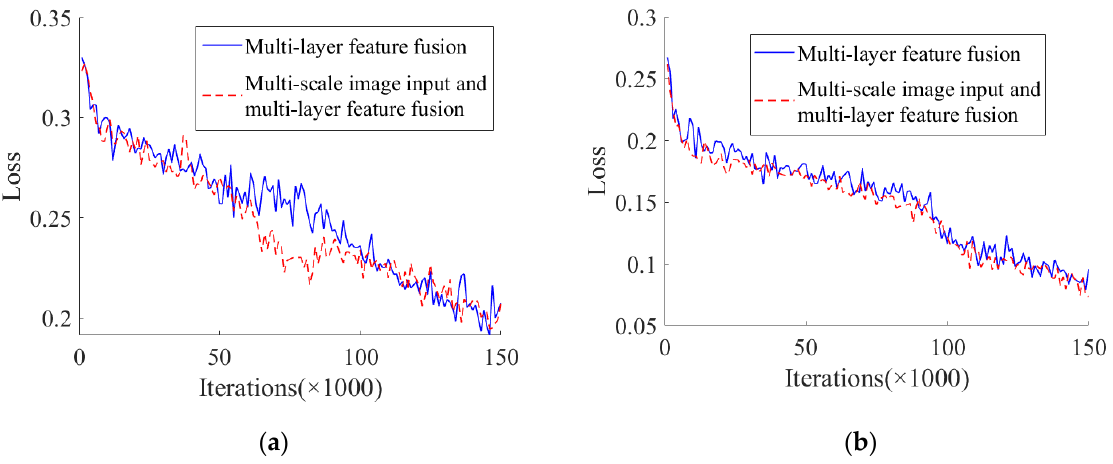
Figure 14. Change curves of the loss function of the improved SqueezeNet + BN-based network with different measures: ( a ) classification loss of the fully connected layer; ( b ) regression loss of the fully connected layer.